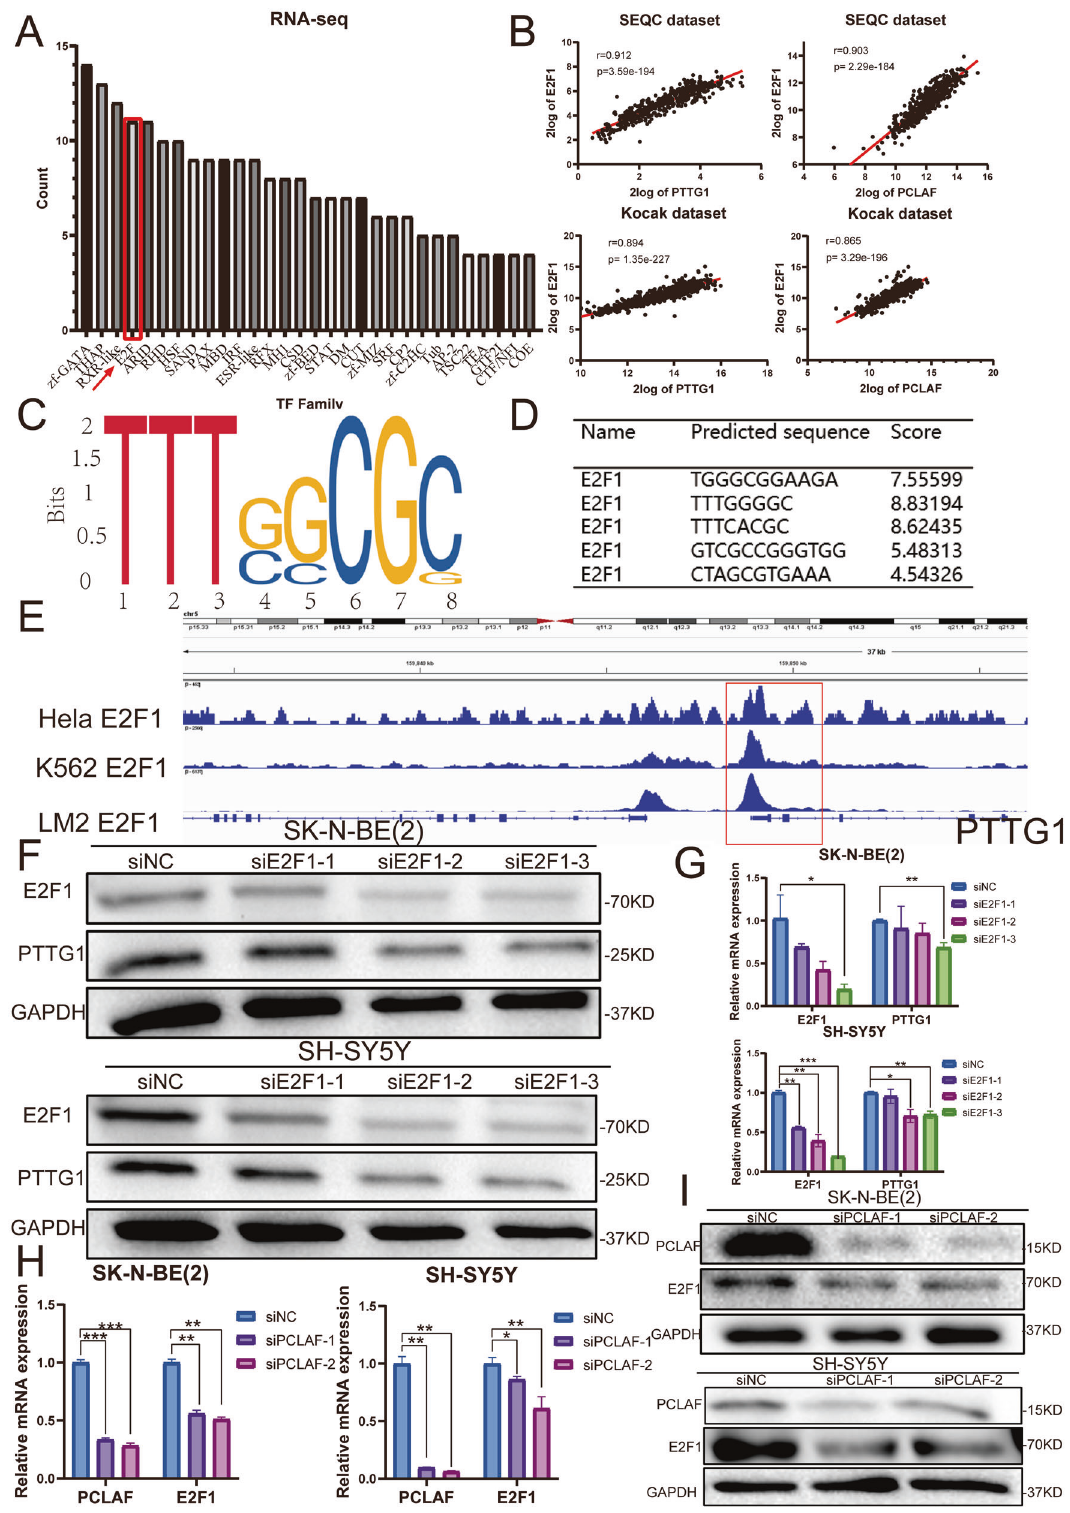
Fig. 5 PCLAF regulates PTTG1 by the transcription factor E2F1. ( A ) Family analysis of transcription factors based on the RNA sequencing data; ( B ) Spearman analysis was used to detect the correlations between PCLAF and E2F1 and PTTG1 in the neuroblastoma database; ( C, D ) Prediction of the sequence logo of E2F1 and the binding sites of E2F1 on the PTTG1 promoter region were predicted by JASPAR; ( E ) Graphical representation of enrichment for E2F1 on the regulatory regions of PTTG1 in HeLa, K562, and LM2 cells. Red boxes show regions with E2F1 enrichment; ( F ) The mRNA level of PTTG1 after decreasing E2F1 by siE2F1 in SK-N-BE (2) and SH-SY5Y cell lines; ( G ) The protein levels of PTTG1 after decreasing E2F1 by siE2F1 in SK-N-BE (2) and SH-SY5Y cell lines; ( H ) The mRNA level of E2F1 after decreasing PCLAF by siPCLAF in SK-N- BE (2) and SH-SY5Y cell lines.; ( I ) The protein levels of E2F1 after decreasing PCLAF by siPCLAF in SK-N-BE (2) and SH-SY5Y cell lines. (* p < 0.05, ** p < 0.01, *** p < 0.001 and **** p < 0.0001, and bar graphs represent the mean ± SEM). Cell Death and Disease (2022)